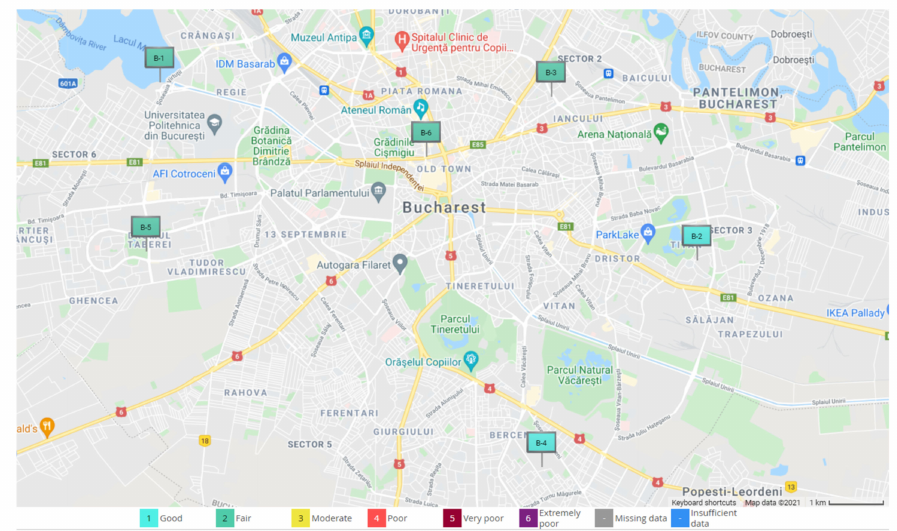
Figure 3. Emplacement of the B-1 to B-6 atmospheric stations in Bucharest [3].